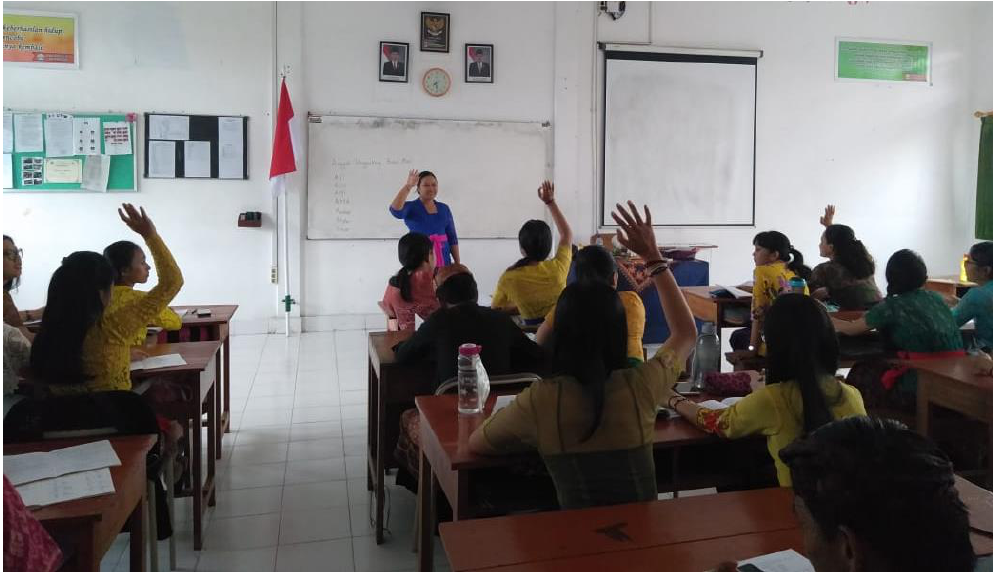
Figure 3. Learning at SMKN 5